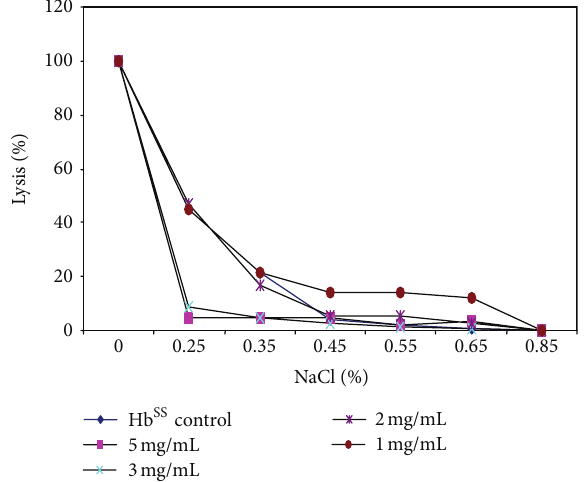
Figure 6: Osmotic fragiliogram after supplementation with various concentrations of Carica papaya